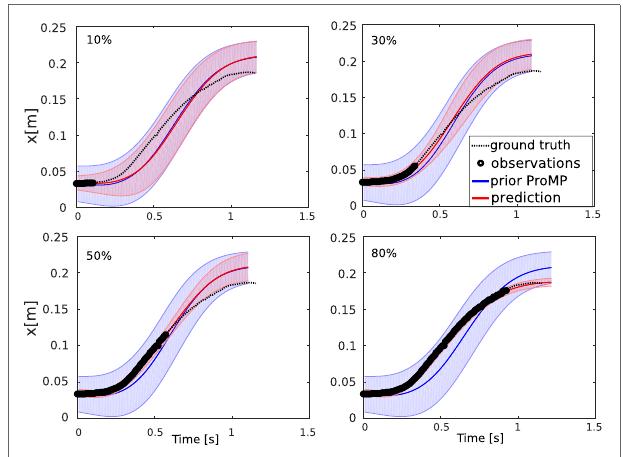
FIGURE 3 | The prediction of the future trajectory given early observations, exploiting the information of the learned ProMP ( Figure 2 ). The plots show the predicted trajectories after 10, 30, 50, and 80% of observed data